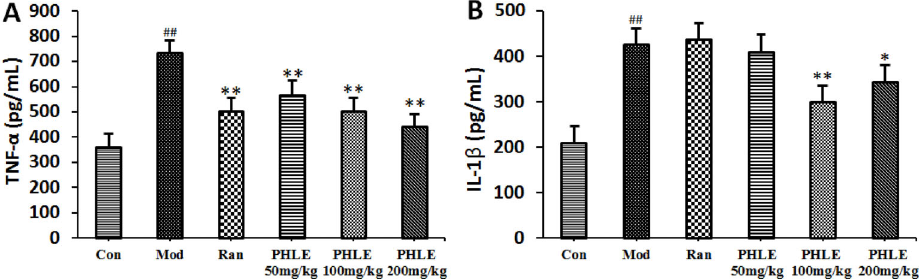
Figure 5. Effects of P. hydropiper extract (PHLE) on tumor necrosis factor (TNF)- a ( A ) and interleukin (IL)-1 b ( B ) levels in the gastric tissues of rats with ethanol-induced gastric damage. The data are reported as means ± SD (n=10). ## P o 0.01 compared to the normal control group (Con), *P o 0.05 and **P o 0.01 compared to the model group (Mod) (ANOVA and LSD post hoc test). Ran: ranitidine (positive control).